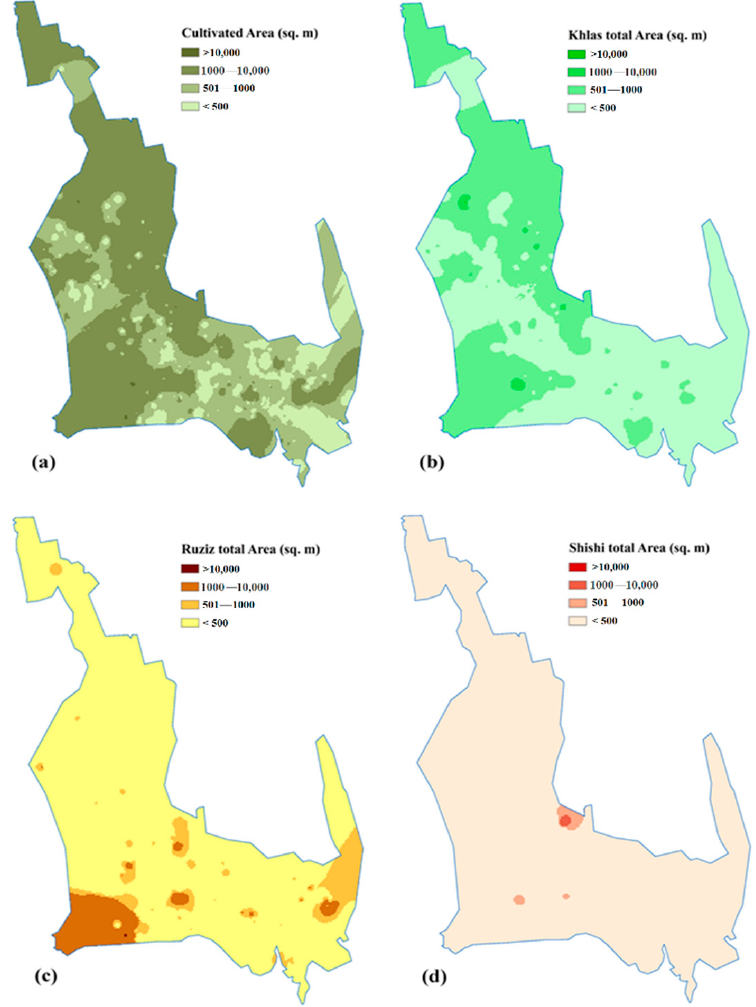
Figure 4. The plot of the cultivated area/farm, as in ( a ) the oasis total palm and in cultivars of ( b ) Khlas, ( c ) Ruziz, and ( d ) Shishi.